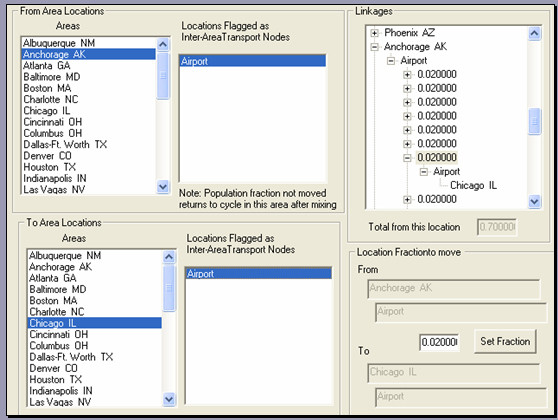
Area linkages panel.